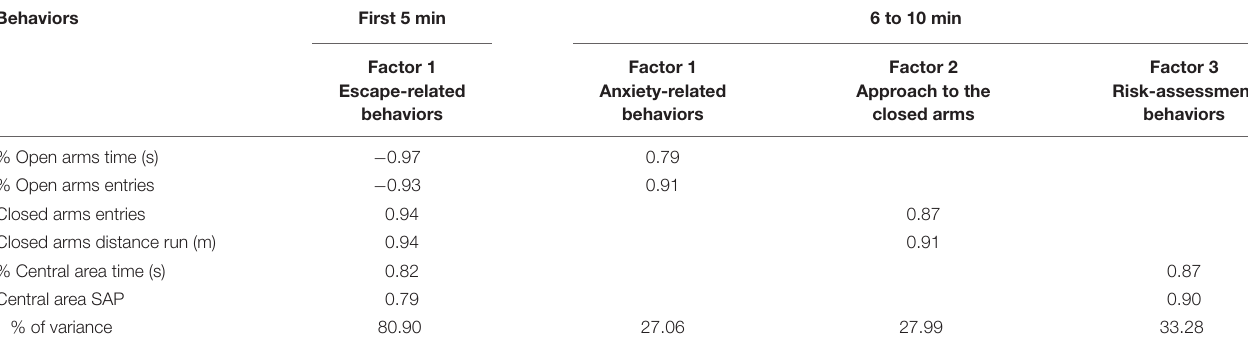
TABLE 2 | Orthogonal factor loadings obtained from control group gerbils for the first 5-min and the following 5-min of the session in the elevated plus-maze test. Behaviors First 5 min 6 to 10 min